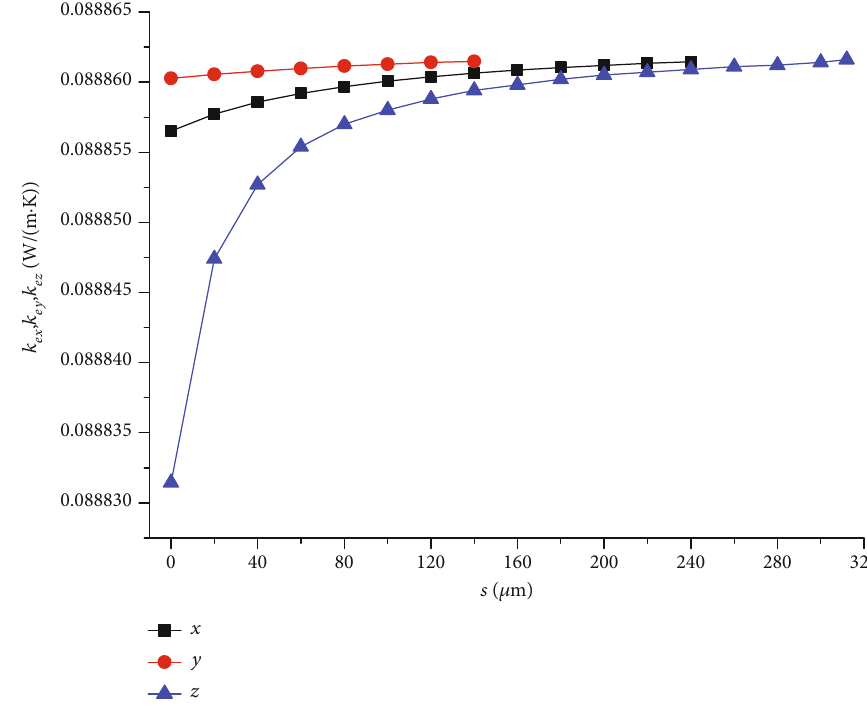
Figure 21: The relationship between thermal conductivity and distance in three directions of fi